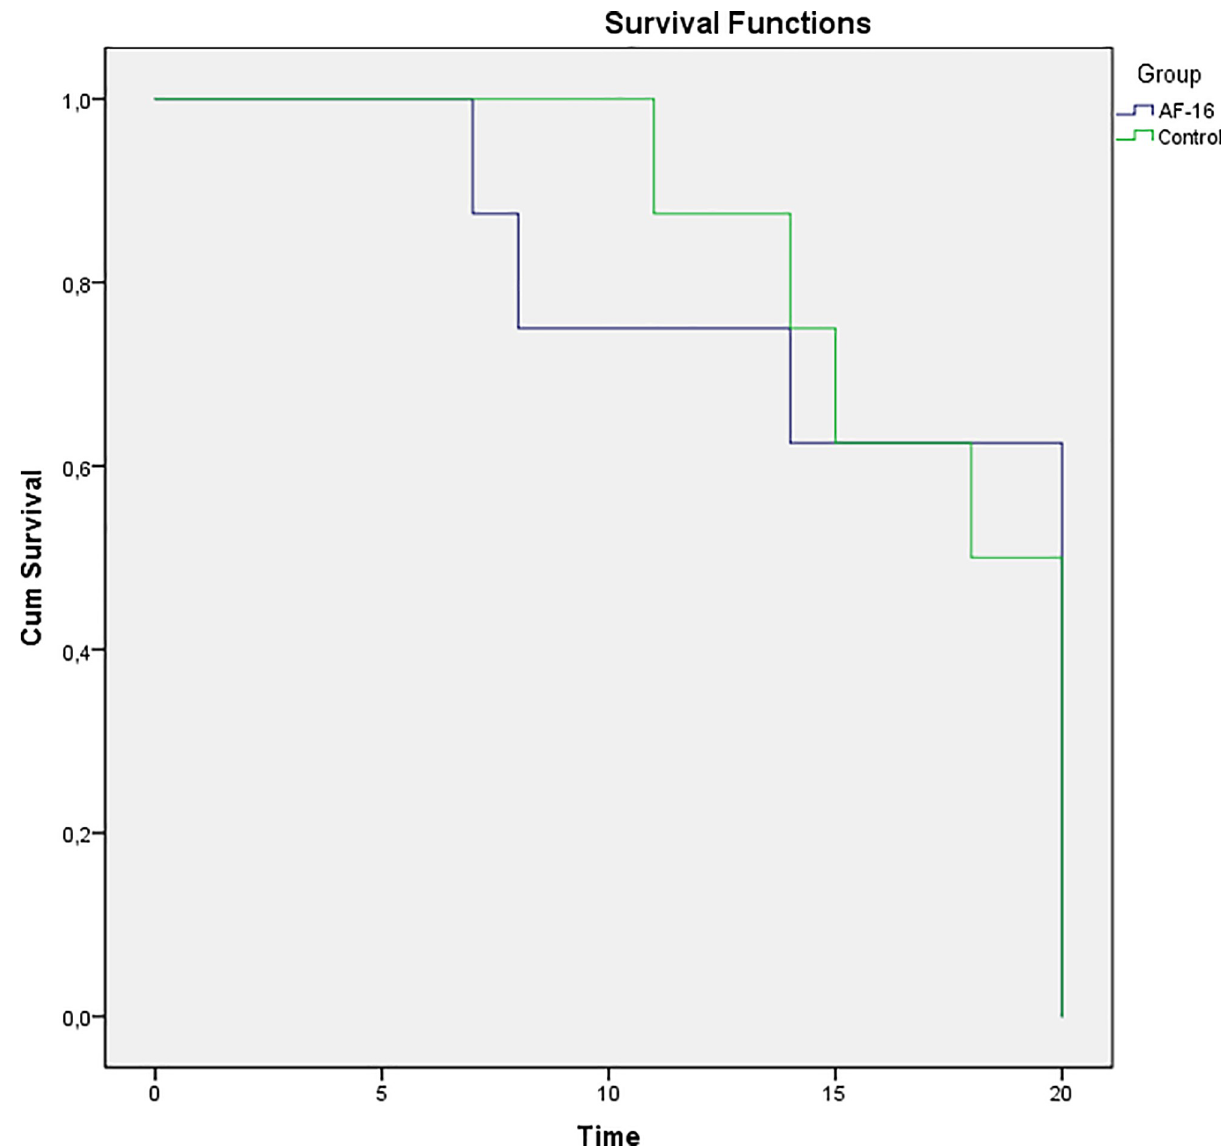
Fig 2. Kaplan-Meyer analysis of survival. Of a total of 8 + 8 animals, 9 survived the experiment until euthanasia (20 hours), while three and four animals died of refractory shock during the 20-hours observation period in treatment and control groups, respectively.